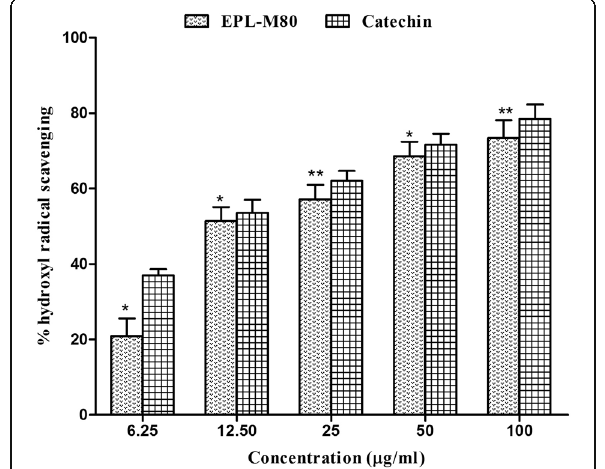
Fig. 4 Hydroxyl radical scavenging activity at different concentrations of EPL-M80 and the reference standard catechin. Results are presented as mean ± SEM ( n = 3). * p < 0.05 and ** p < 0.01 denotes significant difference compared to the